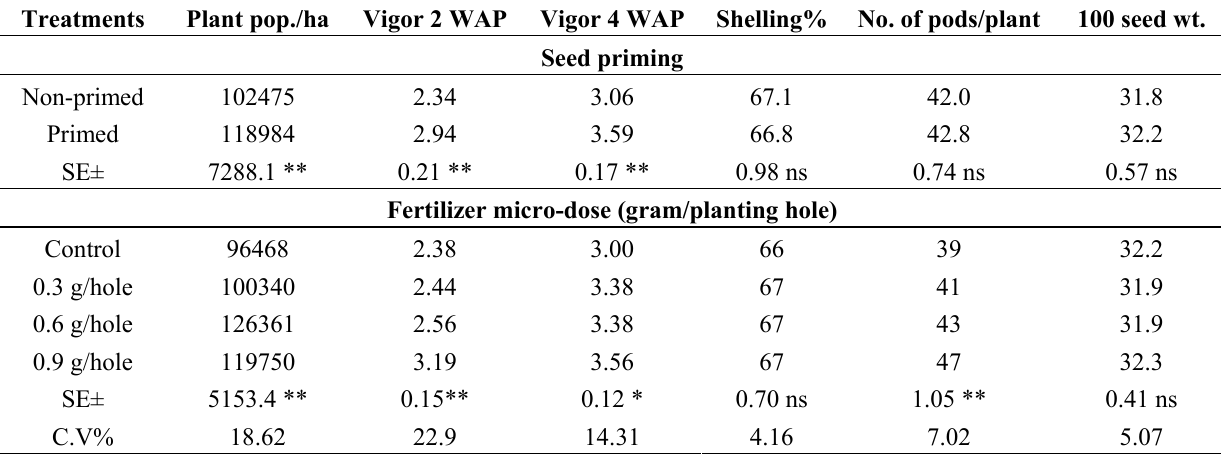
Table 4. Effect of seed priming and micro-dosing on some traits of groundnut (combined across two seasons).